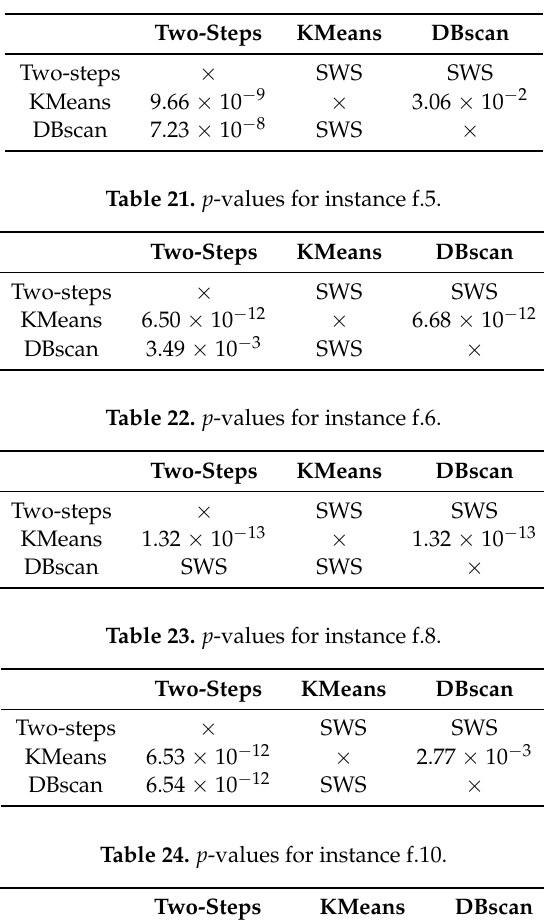
Table 20. p -values for instance f.2.